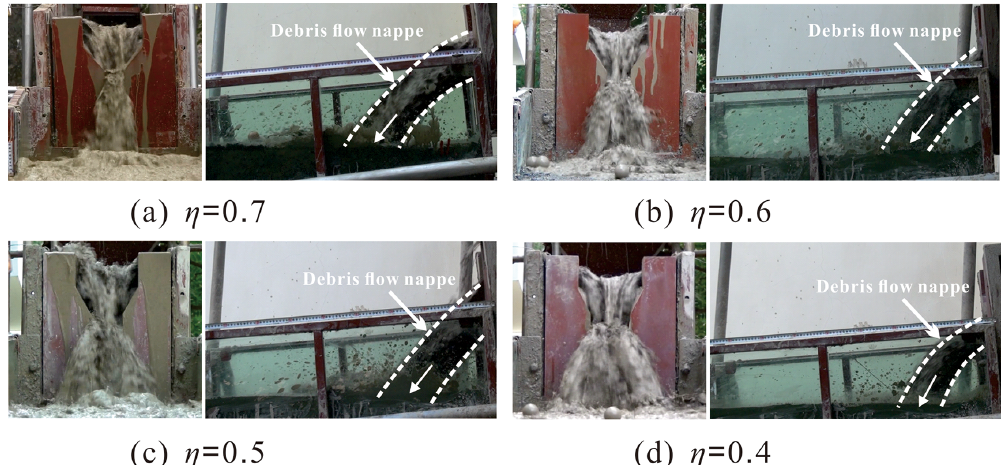
Figure 6. Various debris flow patterns at different lateral contraction ratios (the pictures on the left were taken from a downstream view).